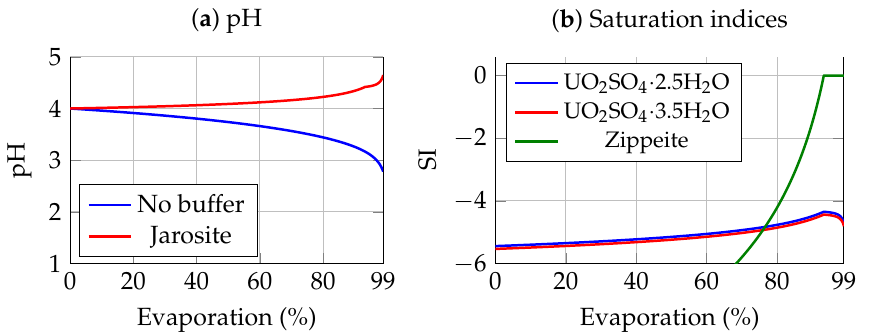
Figure 3. The evolution of the geochemical system during evaporation in a batch-like system. The water content is decreased by a factor 100. ( a ) pH evolution with several buffering minerals. ( b ) Saturation indices (SI) of several uranyl-sulfate minerals from the thermodynamic database with jarosite as the pH buffer mineral.